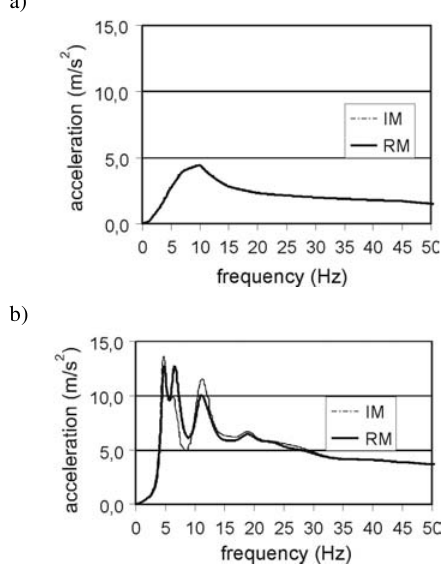
Fig. 12. In-structure horizontal (East-West) acceleration response spectra in selected points at different levels: a – z = 20,0 m,; b – z = 36,0 m